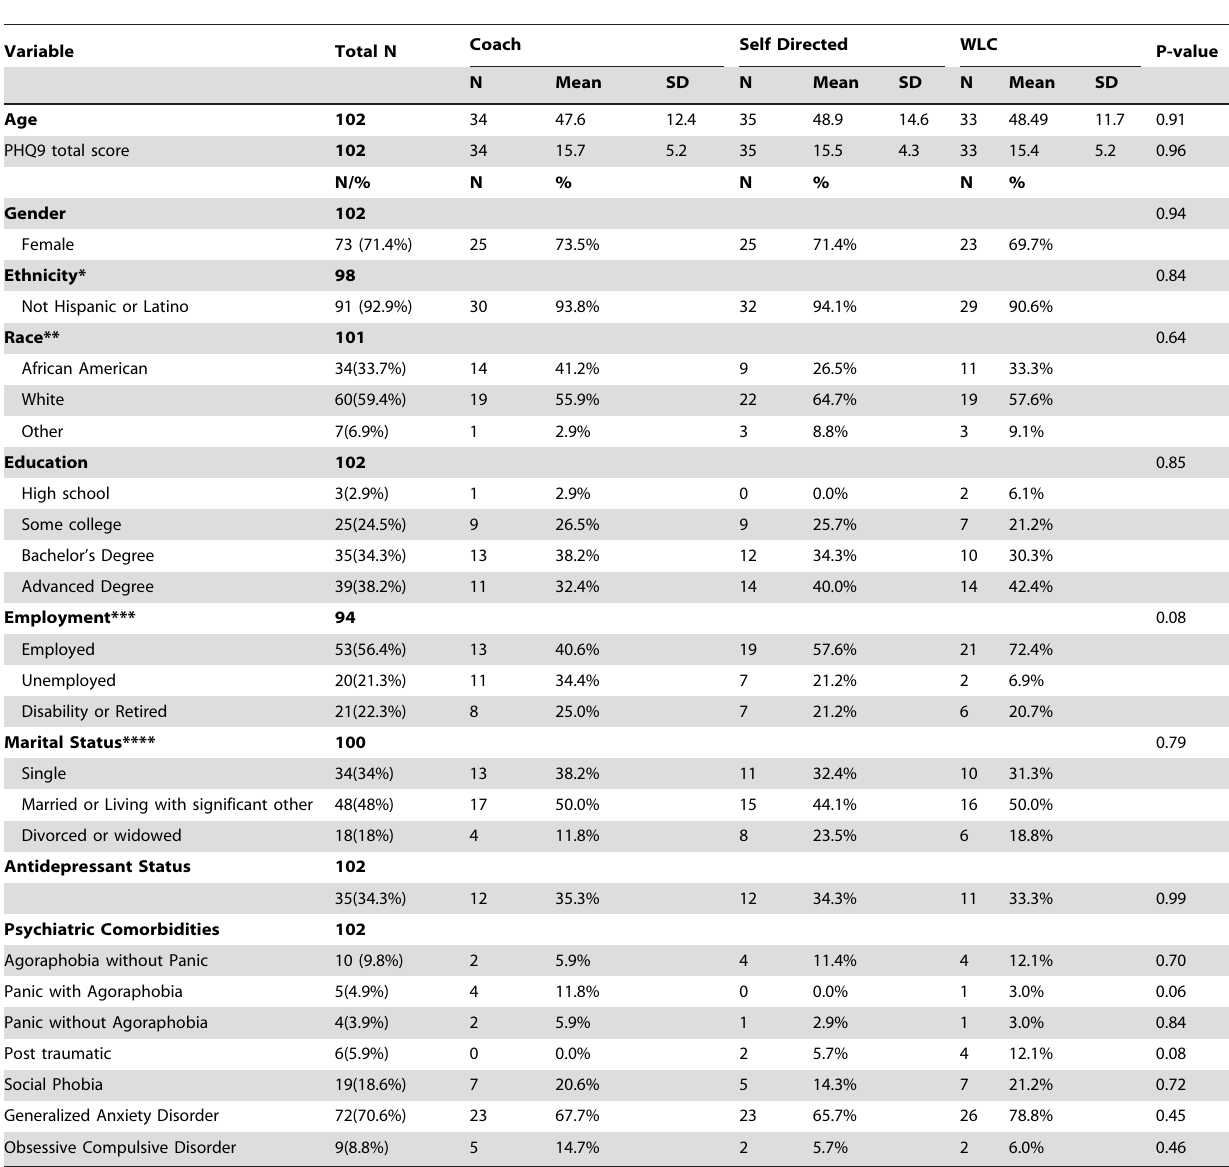
Table 1. Baseline Participant